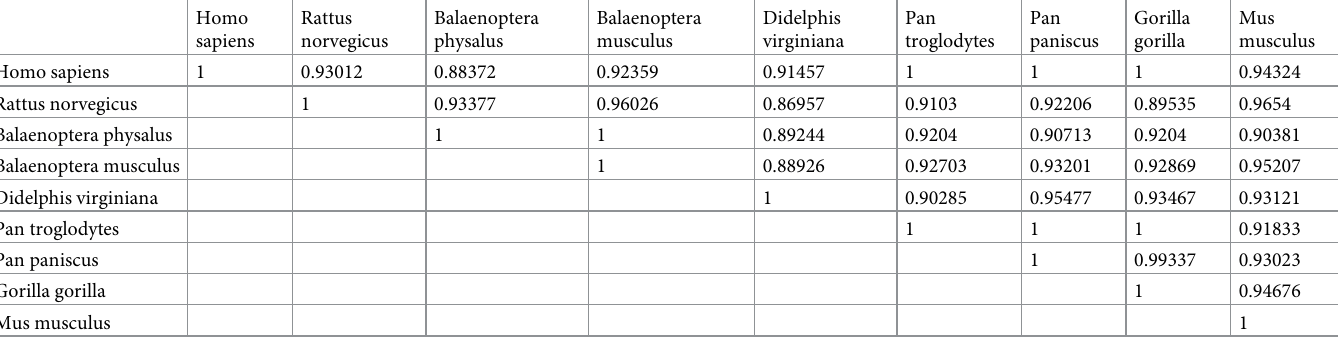
Table 8. The parameter Sensitivity (SEN) of the HELIOS method with referencing the Smith-Waterman algorithm in the accuracy measurement of classification output. The assumed dataset is the “Nine ND5 protein sequences dataset” [53] in this study.